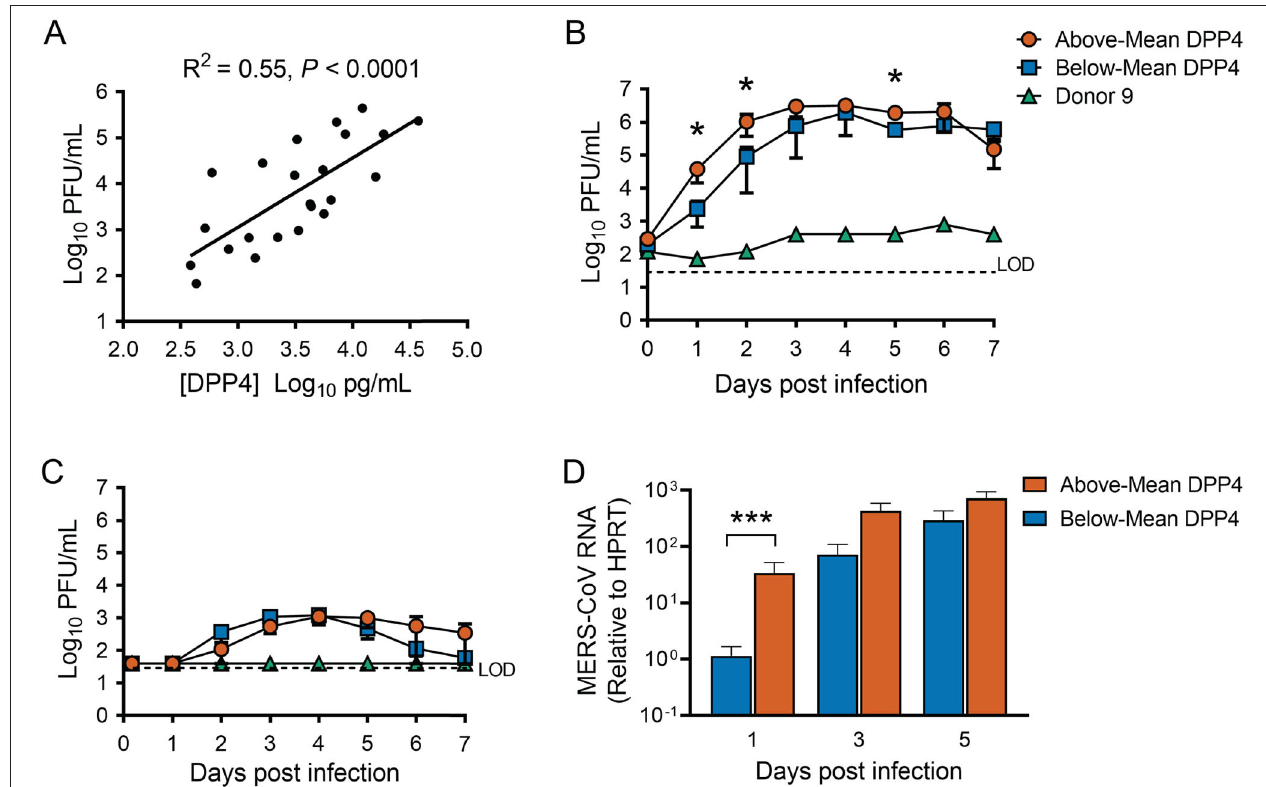
FIGURE 3 | Cellular DPP4 abundance influences MERS-CoV replication in human airway epithelia. (A) HAE ( n = 23) were infected apically with MERS-CoV at an MOI of 0.1, and apical release of progeny virus at 1 day post infection was quantified by plaque assay. Linear regression was performed to assess the relationship between progeny virus titers and cellular DPP4 abundance. (B) HAE were infected apically with MERS-CoV (MOI = 0.1), and viral growth was monitored over a 7-day timecourse by measuring release of progeny virus from the apical (B) or the basolateral compartment (C) . Above-Mean DPP4 group, n = 4; Below-Mean DPP4 group, n = 4. LOD denotes limit of detection. (D) Viral replication was also monitored by QPCR to detect MERS-CoV genomic RNA levels in infected cells. In (B–D) , data were tested for significant differences between the Above-Mean and Below-Mean groups at each timepoint by performing unpaired 2-tailed t -tests on log